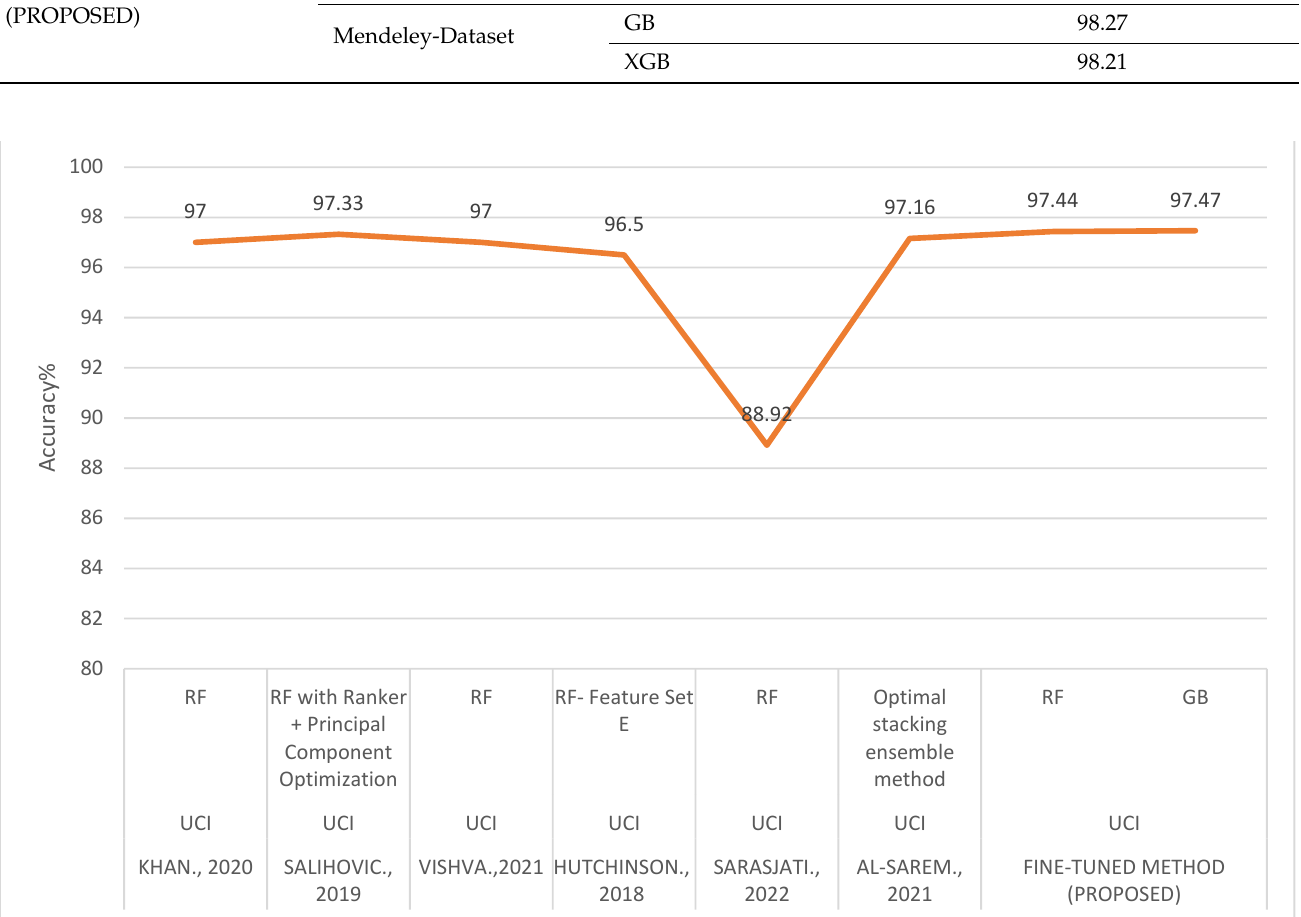
Figure 10. Performance comparison of existing and fine-tuned system for UCI dataset [12–16,19].